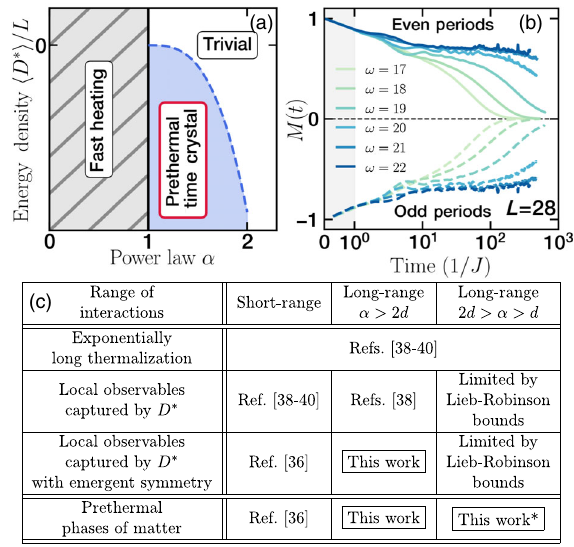
FIG. 1. (a) Schematic phase diagram for a one-dimensional prethermal time crystal as a function of interaction power law and energy density. The 1D PDTC can only exist for long-range interactions (i.e., J ij ∝ j i − j j − α )with power law 1 < α < 2 andan energy density that lies in the symmetry-broken phase of the prethermal Hamiltonian D (cid:2) . (b) PDTC Floquet dynamics depict- ing the magnetization M ð t Þ for a system size L ¼ 28 . The robust period doubling behavior, which survives for exponentially long times in the frequency of the drive ω , signals prethermal time crystalline order. (c) Table summarizing our analytical results. The star indicates that for this case prethermal phases exist provided that we assume that local observables relax to the Gibbs state of D (cid:2) , which we expect since this is the state that maximizes the entropy subject to the constraint of conservation of